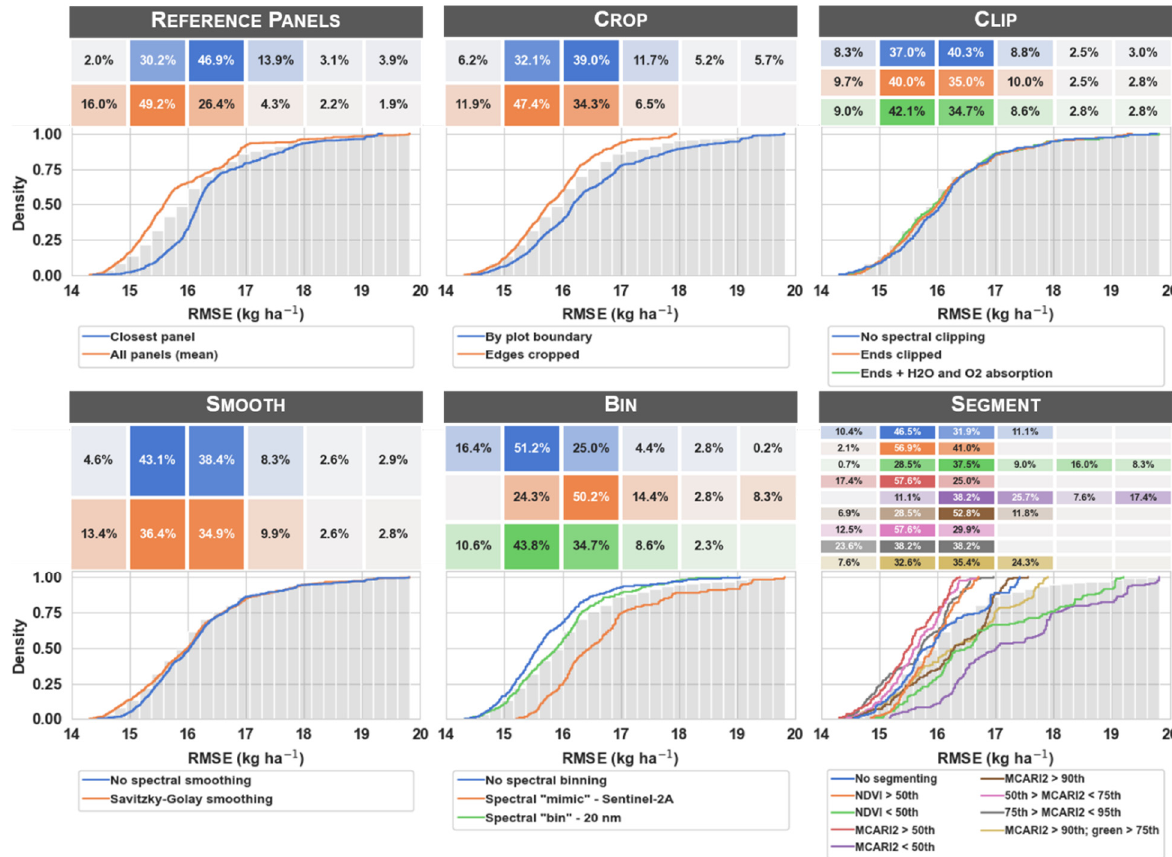
Figure 7. Empirical cumulative density functions (ECDF) for each image processing scenario. At each processing step, the ECDF curves illustrate the cumulative first-order error in predicted maize nitrogen uptake (kg ha − 1 ) for each of the processing scenarios evaluated (colors indicate the different scenarios within each image processing step). The grids above each of the ECDF plots illustrate the proportion of unique processing scenarios represented within the discrete range of RMSE values indicated on the x -axis (e.g., 16% of all unique processing scenarios that used all ref- erence panels for reflectance conversion resulted in a RMSE between 14 and 15 kg ha − 1 , while only 2% of unique scenarios that used the closest panel fell within the same range of error). The grey bars represent the cumulative distribution of RMSE values across all processing steps and scenarios (included as a reference). The RMSE values were calculated for each workflow scenario based on lasso and partial least squares supervised regression estimators (RMSE n = 1296).